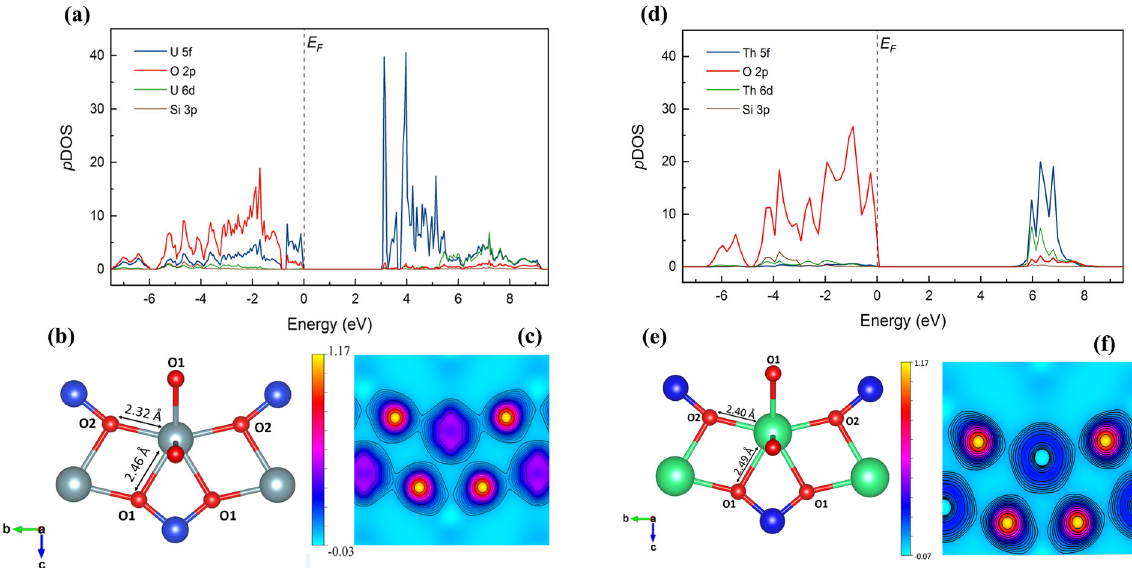
Fig. 7 Projected density of states and charge density of USiO 4 and ThSiO 4 . a Projected density of states ( p DOS) diagram of USiO 4 in an AFM magnetic order. b Representation of the half plane bisecting the <U – O1> and <U – O2> bonding, where the gray spheres are U, the blue spheres are Si, and red spheres are O. c Charge density in units of e Å − 3 corresponding to the half plane presented in b . d Projected density of states ( p DOS) diagram of ThSiO 4 . e Representation of the half plane bisecting the <Th-O1> and <Th-O2> bonding, where the green spheres are Th, the blue spheres are Si, and red spheres are O. f Charge density in unit of e Å − 3 corresponding to the half plane presented in e .